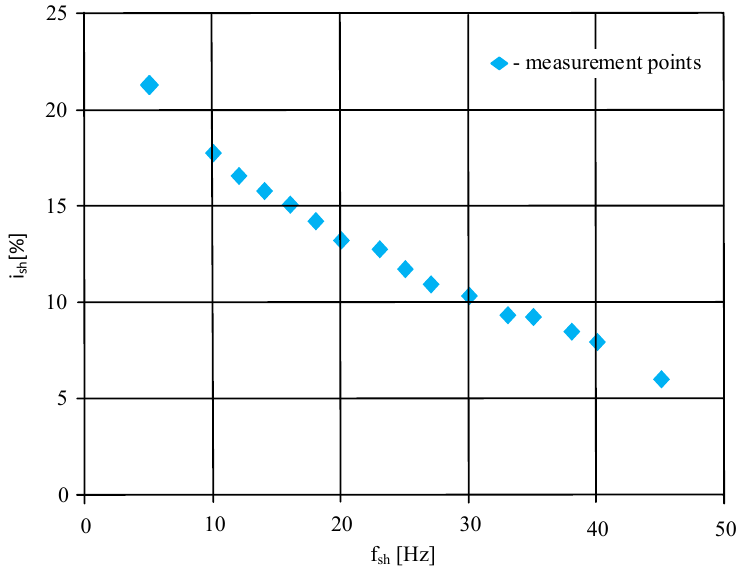
Figure 9. Measured current subharmonics vs. the subharmonic frequency for motor 3 Case A . In summary, negative sequence VShs may cause excessive vibration. However, in the case of the investigated motor, the vibration levels are significantly lower than under a positive sequence VShs